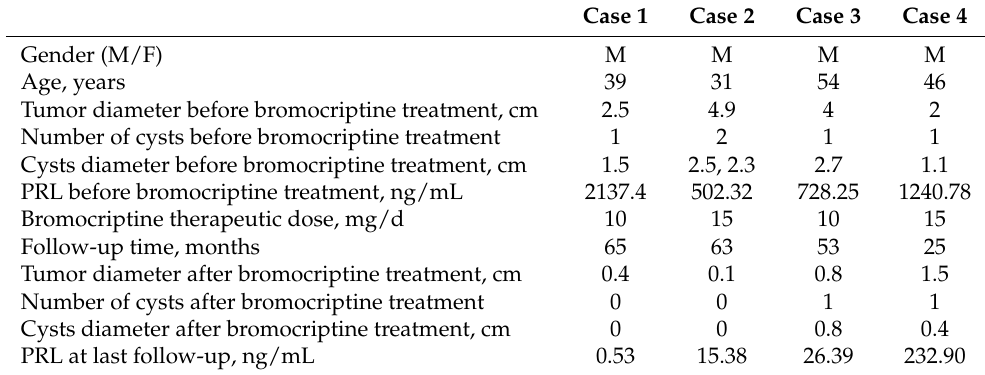
Table 3. Clinical characteristics and outcomes of 4 patients treated with bromocriptine for a long